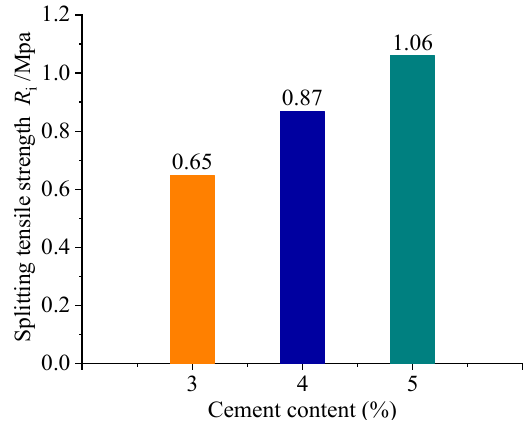
Figure 17. Test results of splitting tensile.